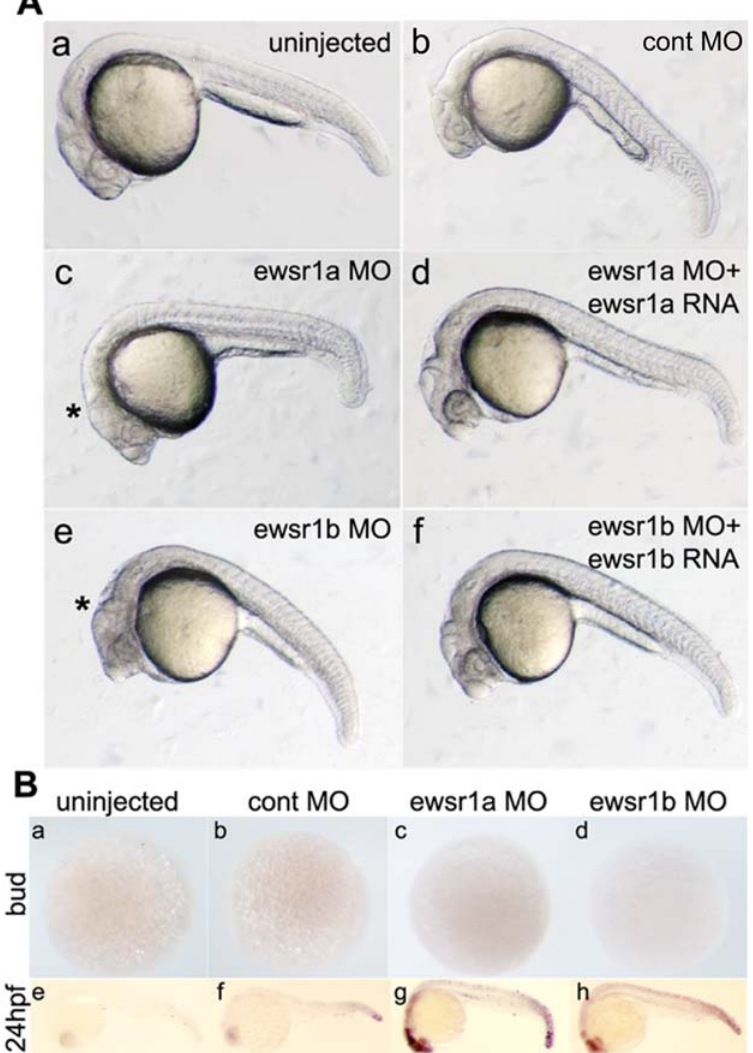
Figure 3. MO-Induced Knockdown of Zebrafish ewsr1a and ewsr1b Results in Morphologic Abnormalities in the CNS Accompanied by Apoptosis. A. (a) uninjected, (b) control morpholino (MO), (c) ewsr1a MO , (d) ewsr1a MO with ewsr1a mRNA , (e) ewsr1b MO, and (f) ewsr1b MO and ewsr1b mRNA co-injected embryo. Both ewsr1a and ewsr1b MO injected embryos show dark cells (c and e) in the brain. The asterisk (*) indicates increased apoptosis and abnormal MHB. Co-injection of MO and mRNA rescued normal brain morphology (d and f). All of the images are lateral views of 24hpf zebrafish embryos. B. No increase of apoptosis in the bud stage (a–d), increased apoptosis in the CNS of ewsr1a and ewsr1b -MO injected embryos at 24hpf (g and h compared to e and f). Lateral views of wild type (a and e), control MO injected embryo (b and f), ewsr1a MO injected embryo (c and j) and ewsr1b MO injected embryo (d and h), after TUNEL staining.